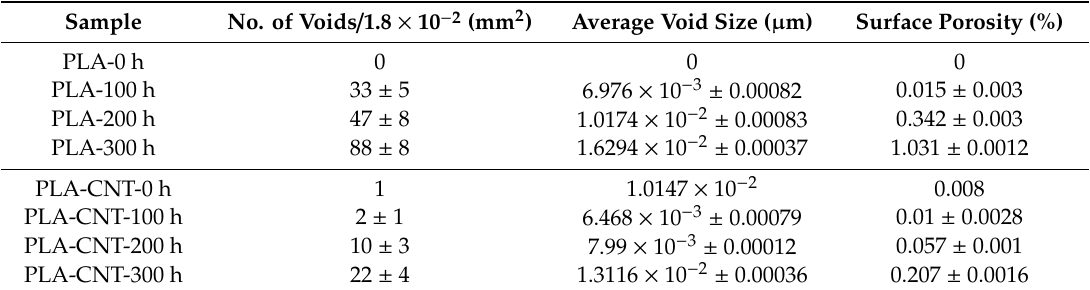
Table 2. Thermal properties of PLA and its nanocomposite before and after degradation